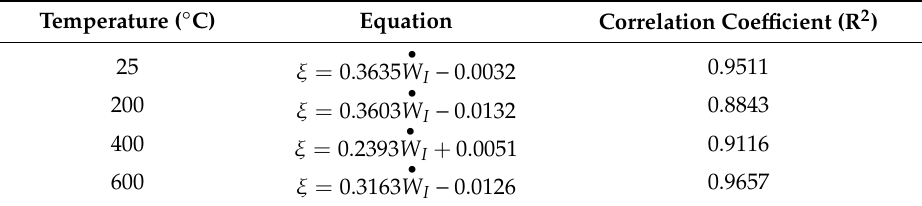
Table 5. Energy results of the SHPB test of concrete after di ff erent temperatures. Temperature ( ◦